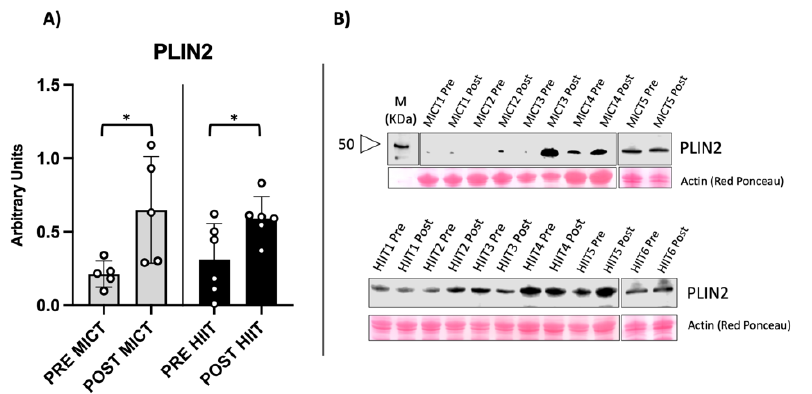
Figure 4. Perilipin 2 protein content. PLIN2 is a protein involved in LD formation. ( A ) Histogram showing significant increase in PLIN2 expression in both groups. ( B ) Example of the immunoblot obtained from vastus lateralis. Western blot results are derived from two separate blots as shown in the figure. * = p ‐ value < 0.05 ( p = 0.031 in MICT and 0.037 in HIIT).